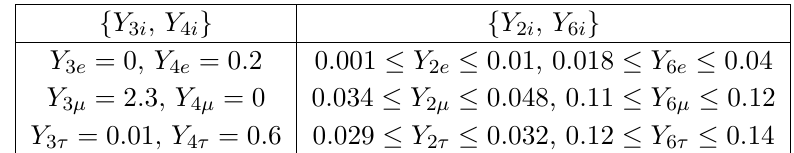
Table 5 . Allowed range of { Y 2 i , Y 6 i } as obtained from eq. (4.2) (for M S = 130 GeV, M f = 800 GeV and M = 300 GeV) within which the magnitudes of the neutrino mass matrix elements for η NH [eq. (4.5)] can be